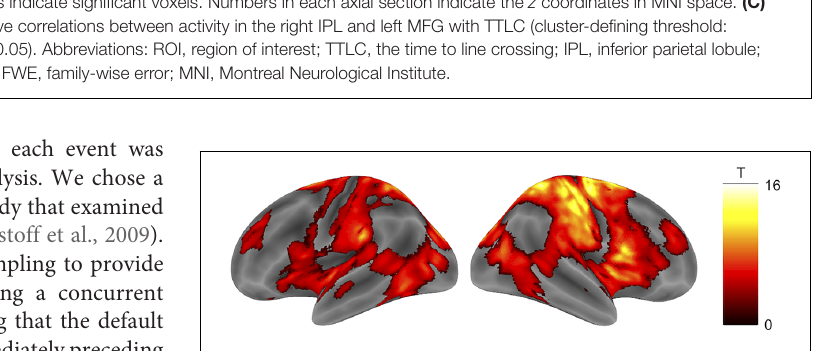
FIGURE 3 | Brain activity negatively correlated with TTLC. Activity in wide-ranging bilateral cortical areas, especially the right sensorimotor cortex, was negatively correlated with TTLC (cluster-defining threshold: p < 0.001 uncorrected; cluster-extent threshold: p FWE < 0.05). Abbreviation: TTLC, the time to line